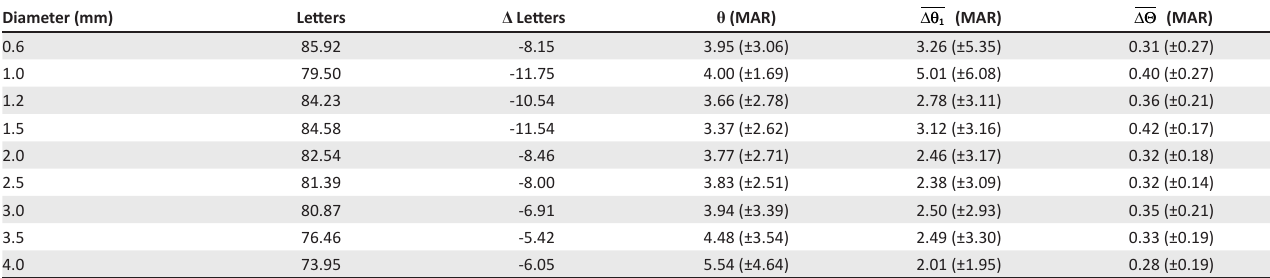
TABLE 5: Mean values for improved scotopic adjusted conditions. Diameter